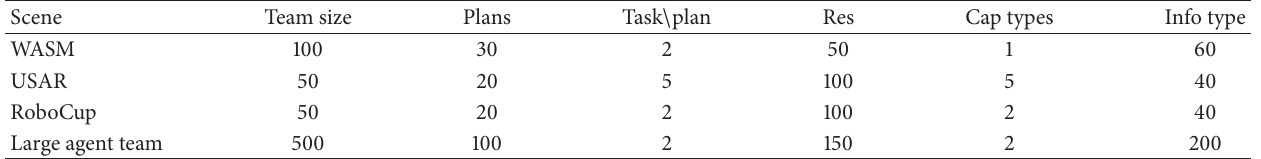
Figure 7: The interface for displaying interaction between networked agents. Table 1: Characters and settings of different application